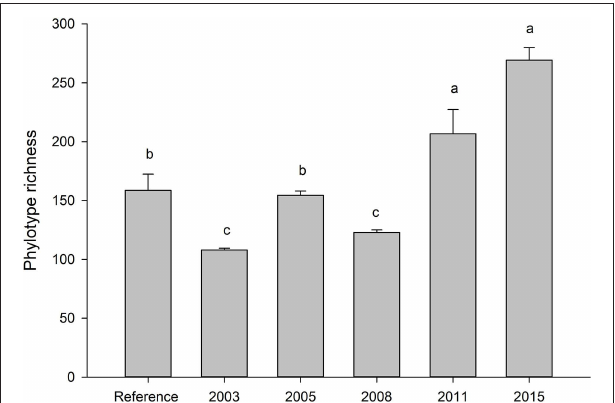
FIGURE 1 | Average (SE) number of fungal phylotypes across the restoration chronosequence. Letters indicate significance at p < 0.05 (Tukey). Values represent a mean of five samples. Ref indicates soils taken from an adjacent, undisturbed “reference” site.